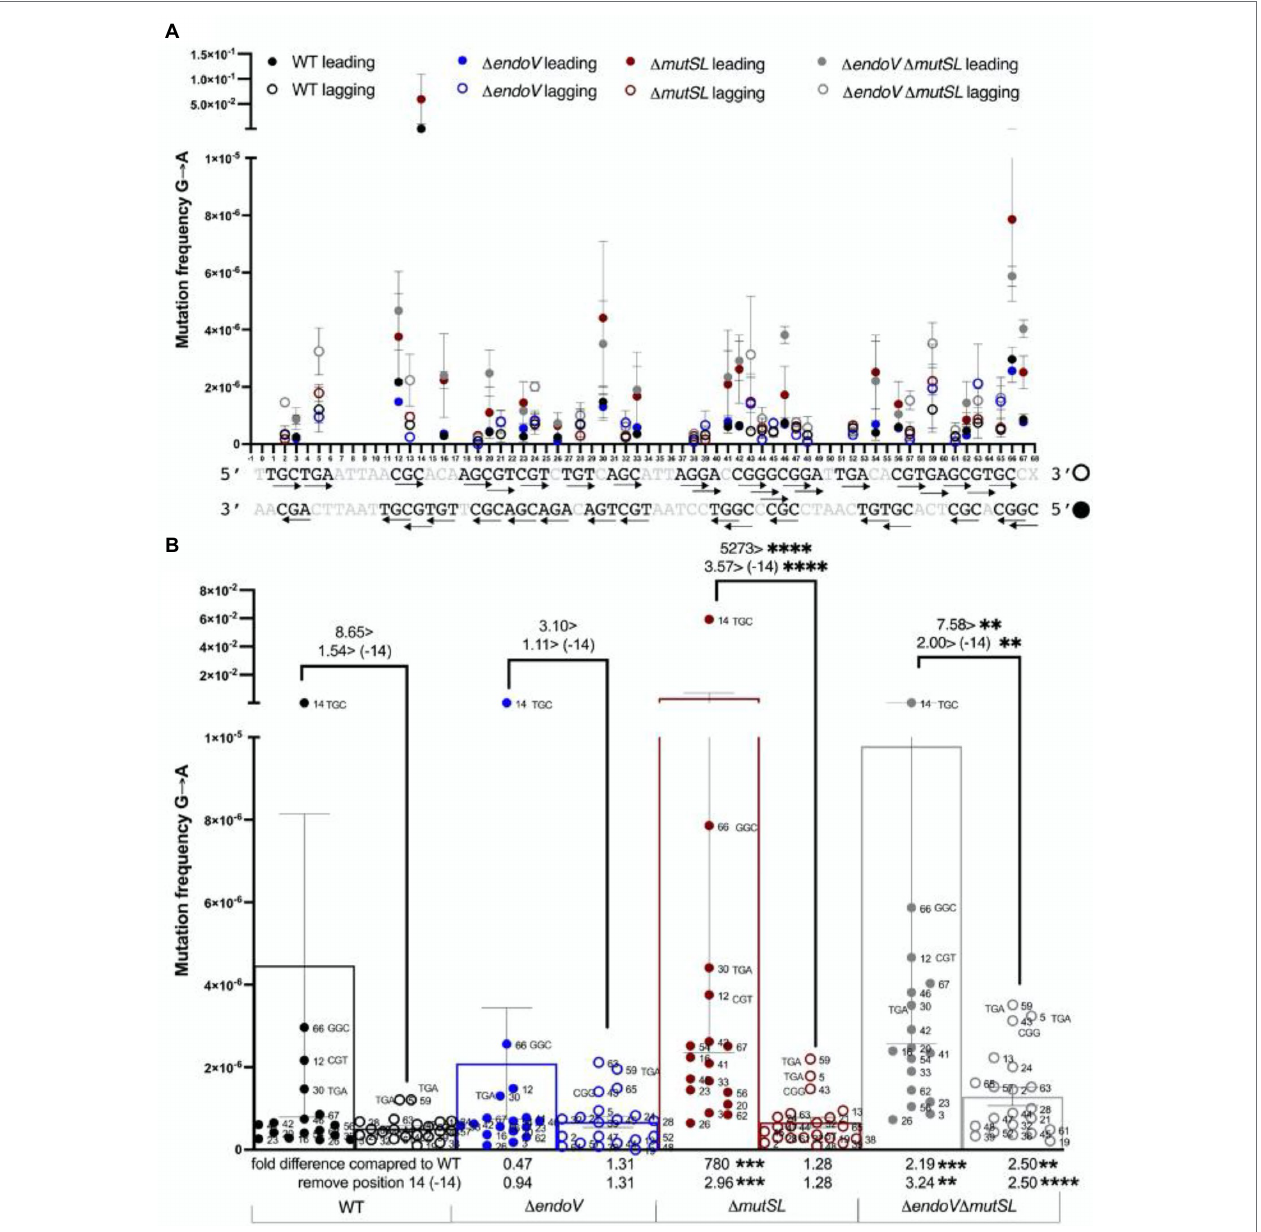
FIGURE 6 | Maximum Depth Sequencing of G → A substitutions in the leading and lagging strands of the B. subtilis strains indicated. (A) G → A Mutation frequency of every G position in each strand of the 68-bp ROI. The arrow → follows 5 ′ → 3 ′ polarity. Closed circles represent the leading strand, while open circles represent the lagging strand. (B) The bars represent the average frequency across the ROI considering the frequency of every G position (dots). Each dot represents the average frequency of two biological replicates. Error bars are SEM. Values (considering or not the contribution of the hot-spot 14), and symbol >, above connecting lines indicate times differences of mutation frequencies between the leading and lagging strand of each strain. Values in X axis, compare times differences of mutation frequencies (considering or not the contribution of the hot-spot 14) between the leading and lagging strands of the mutant strains with those from the WT. **, p < 0.0014 (above) and p < 0.0014 (below); ***, p < 0.0002; ****, p < 0.0001 (by the Mann–Whitney